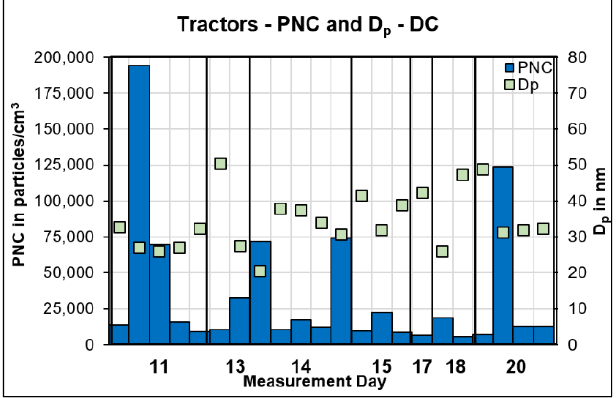
Figure 27. DC DiSCmini (testo) levels from tractors on ( a ) day 11 and ( b ) day 20.